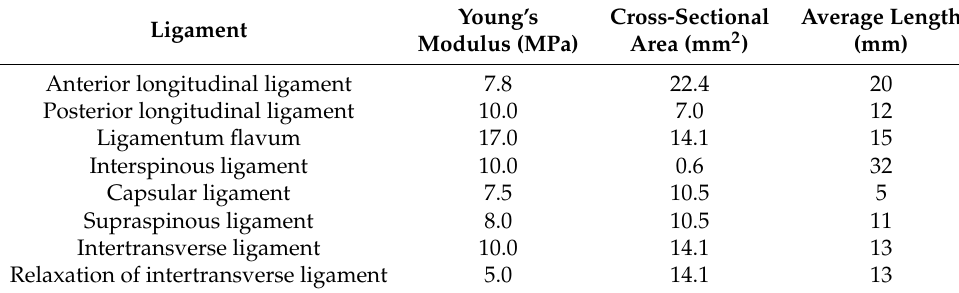
Table 2. Material properties of